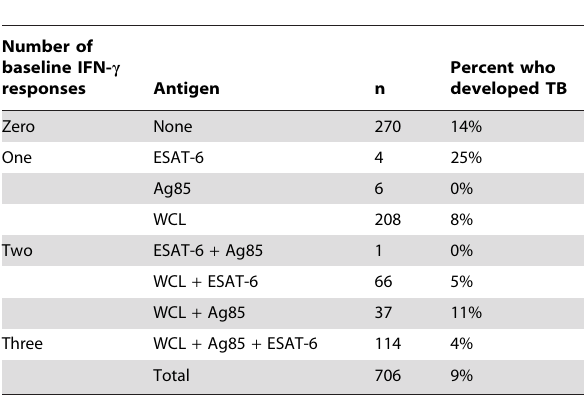
Table 1. Percentage of subjects who developed HIV- associated TB during longitudinal follow up according to antigen specificity of baseline IFN- c